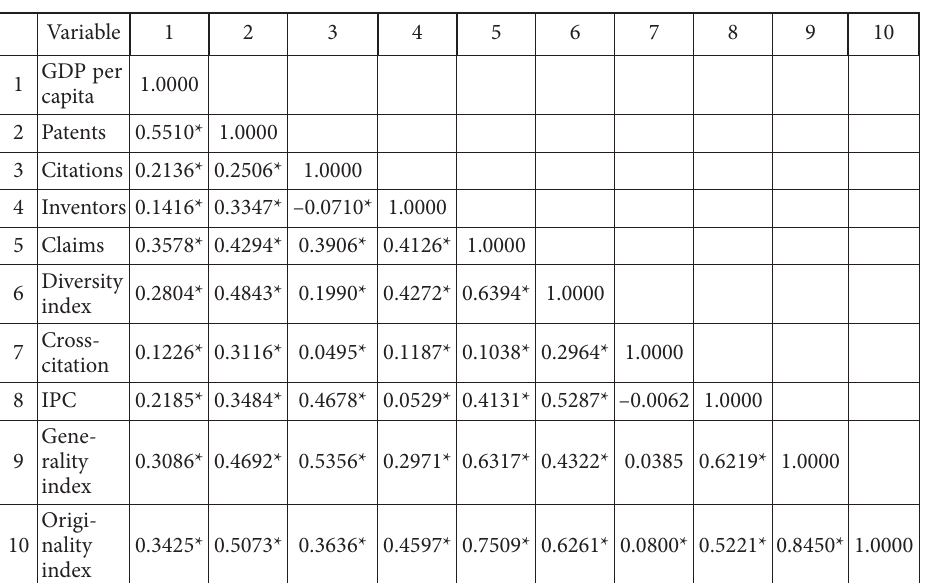
Table 3. Pairwise correlations (with 2SLS first stage diversity index